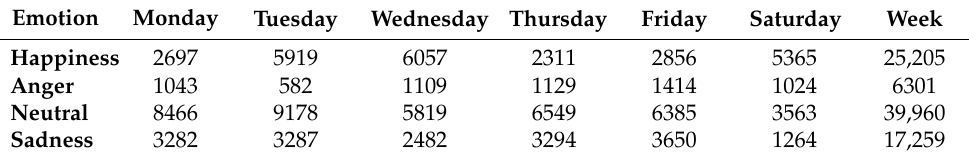
Table 4. Overall results per day and per week; results by emotion to the day and the week (week 2). Emotion